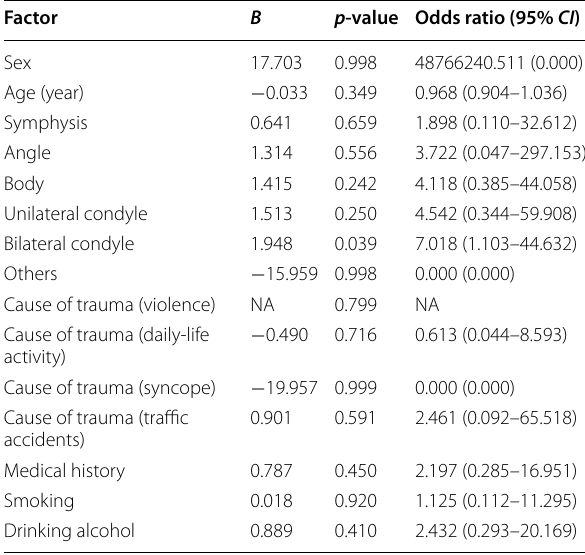
Table 5 Logistic regression analysis of patients with angle